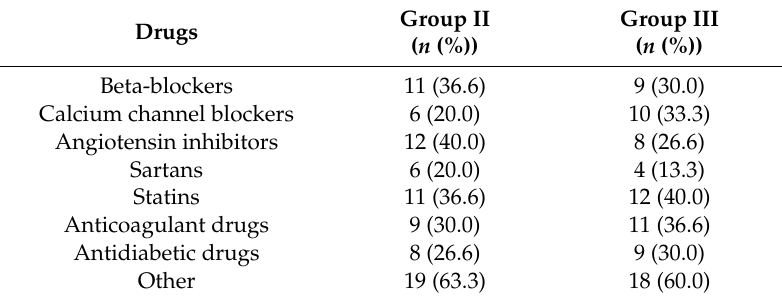
Table 3. Drugs used by elderly patients without (group II) and with (group III) depressive mood